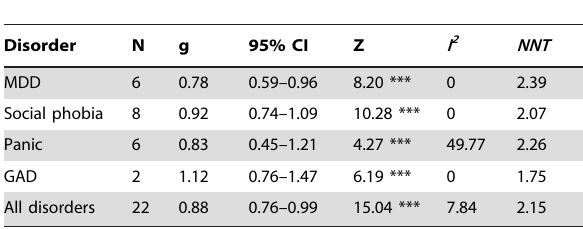
Table 2. Summary results of meta-analyses examining the effects of internet- and computerized CBT for depression and anxiety